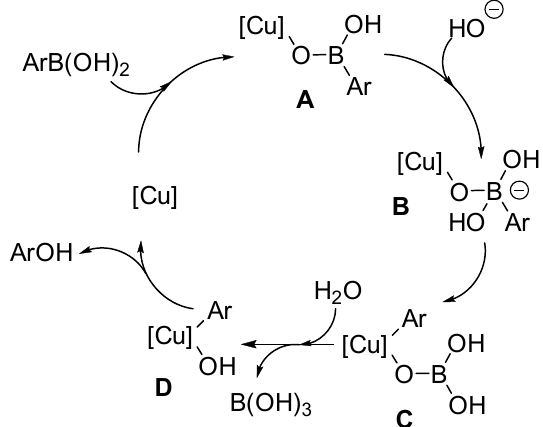
(iv) reductive elimination releasing the phenol derivative [35] (Figure 8).